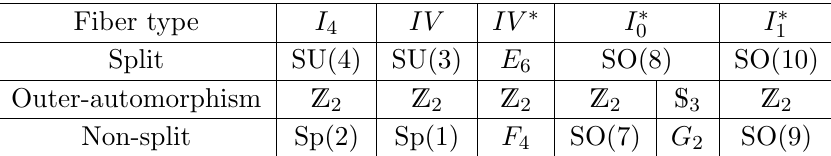
Table 1 . Simply-laced and non-simply-laced Lie algebras that are analyzed in this paper. p (cid:0) (cid:1) =2 i (2) 1 = 3 3 + i f ( (cid:0) g ) 2 = 3 + 3 i 2 2 = 3 x 3 12 g p (cid:0) (cid:0) (cid:1) C e i(cid:18) 2 2 i 3 + i f ( (cid:0) g ) 1 = 3 + 3(2) 1 = 3 1 +